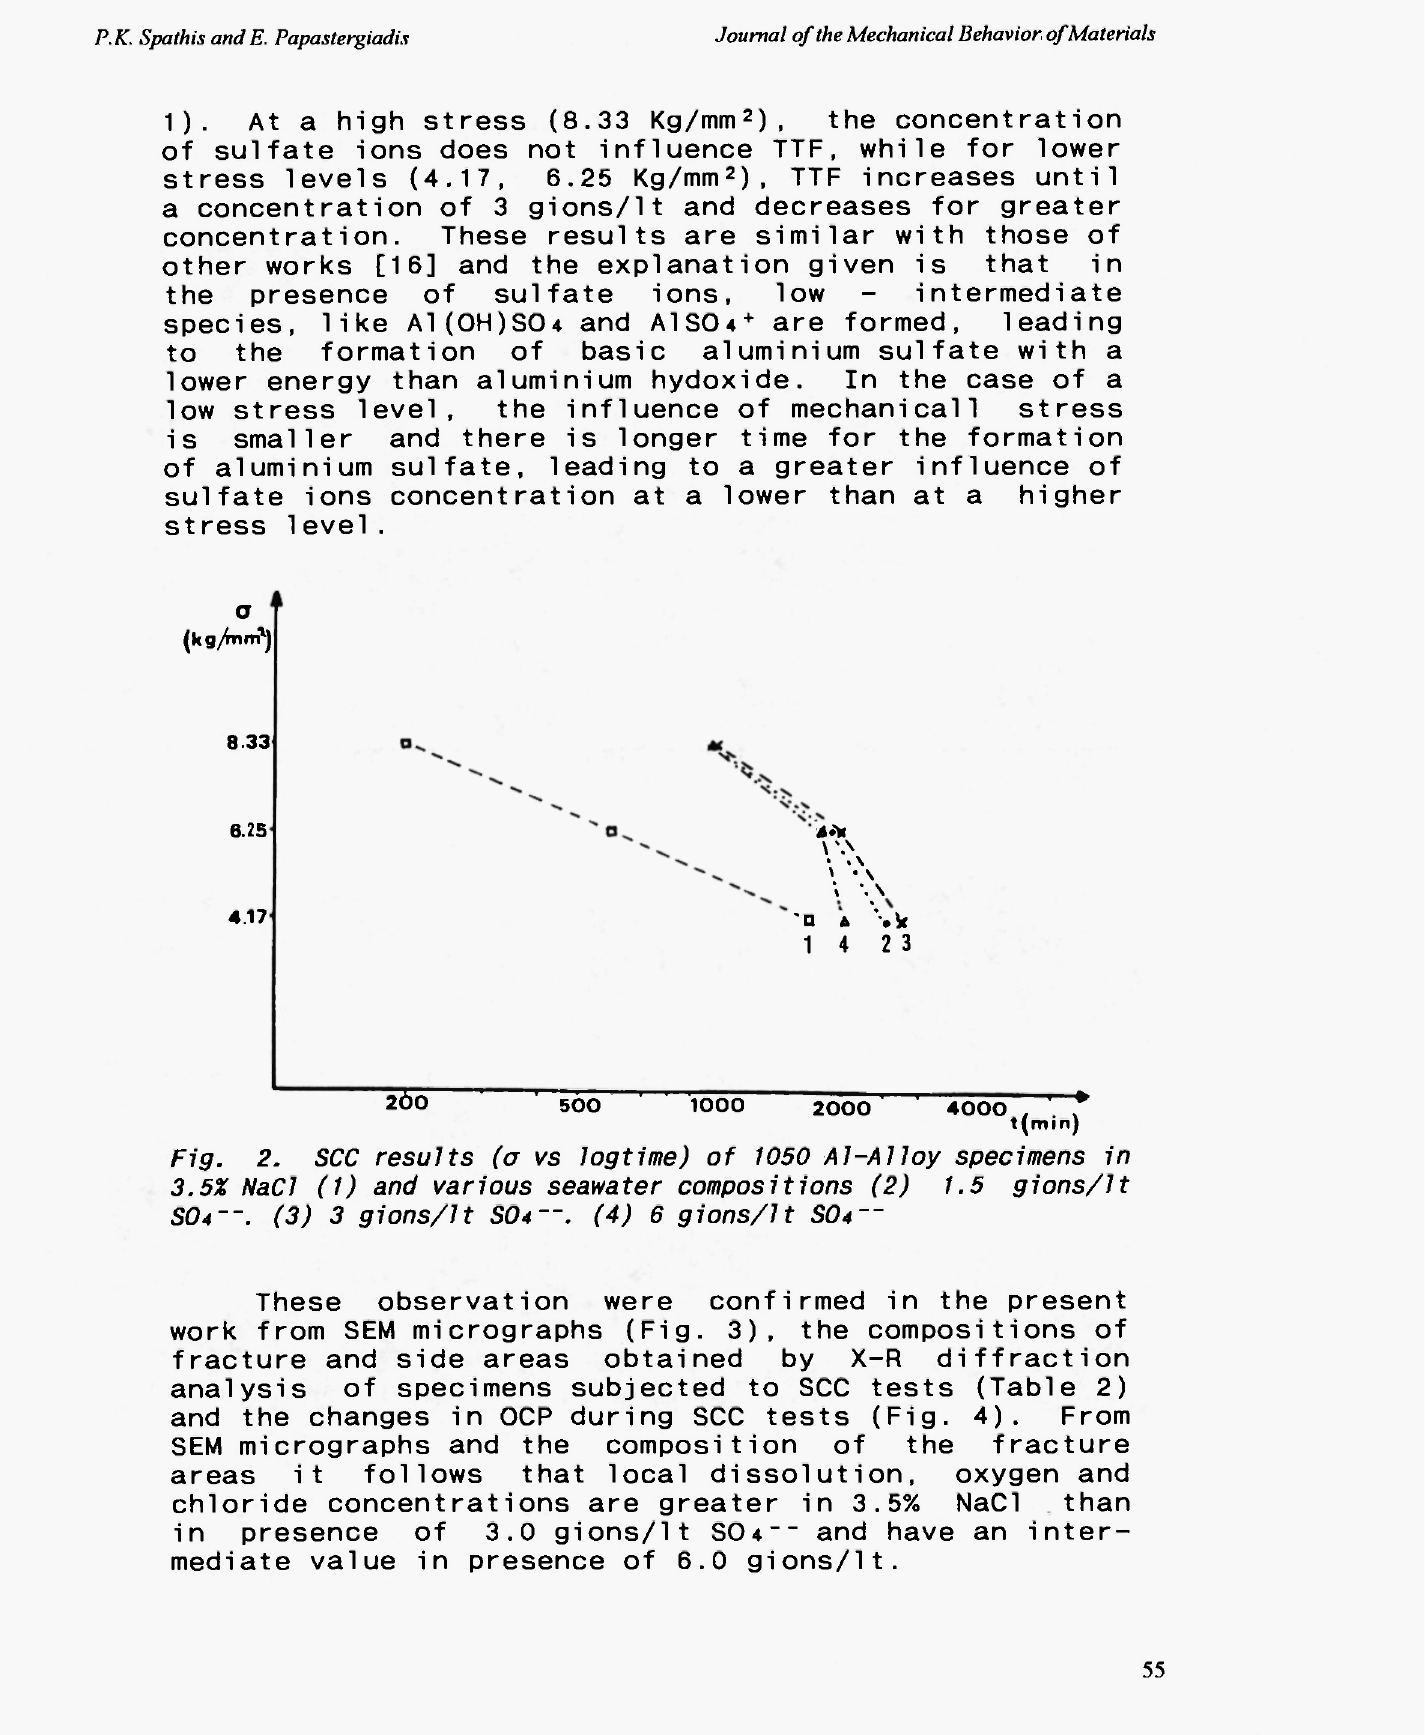
Fig. 2. SCC results (a vs logtime) of 1050 Al-Alloy specimens in 3.5% NaCl (1) and various seawater